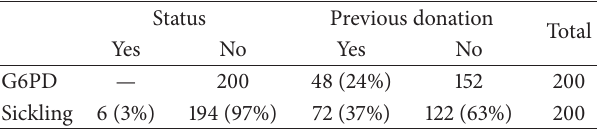
Table 2: Knowledge of blood donors on G6PD deficiency and/HbS status.